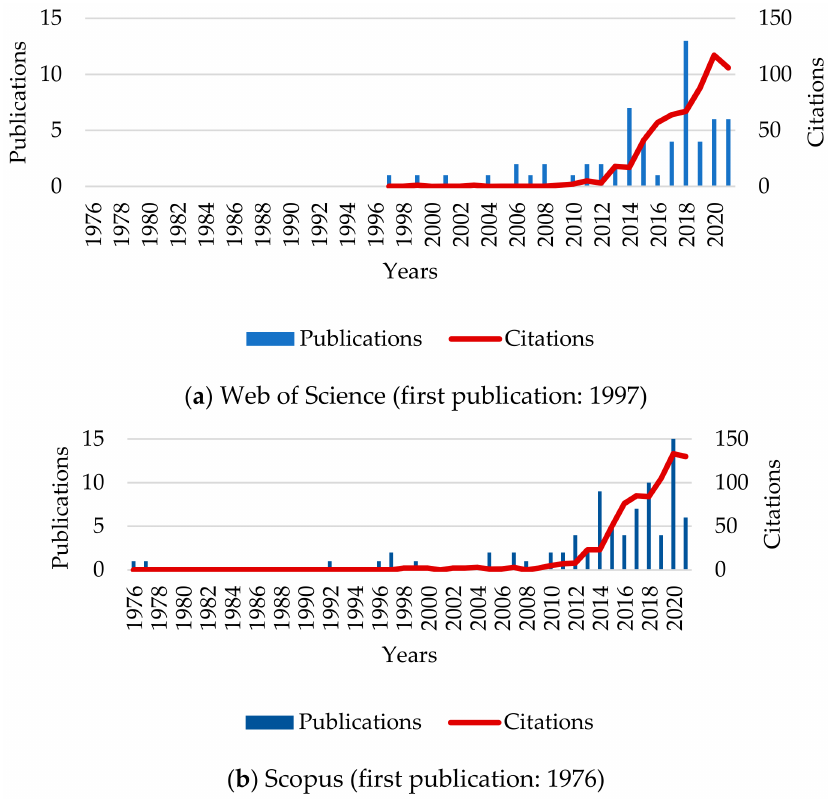
Figure 2. Publications and citations over the years in ( a ) Web of Science; ( b ) Scopus. Source: own